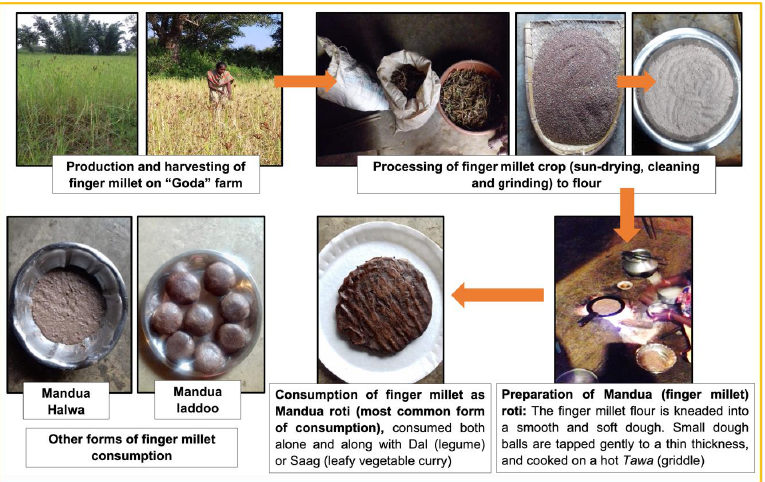
Figure 3. The different steps in the value chain of finger millet in Khunti district, Jharkhand, India.